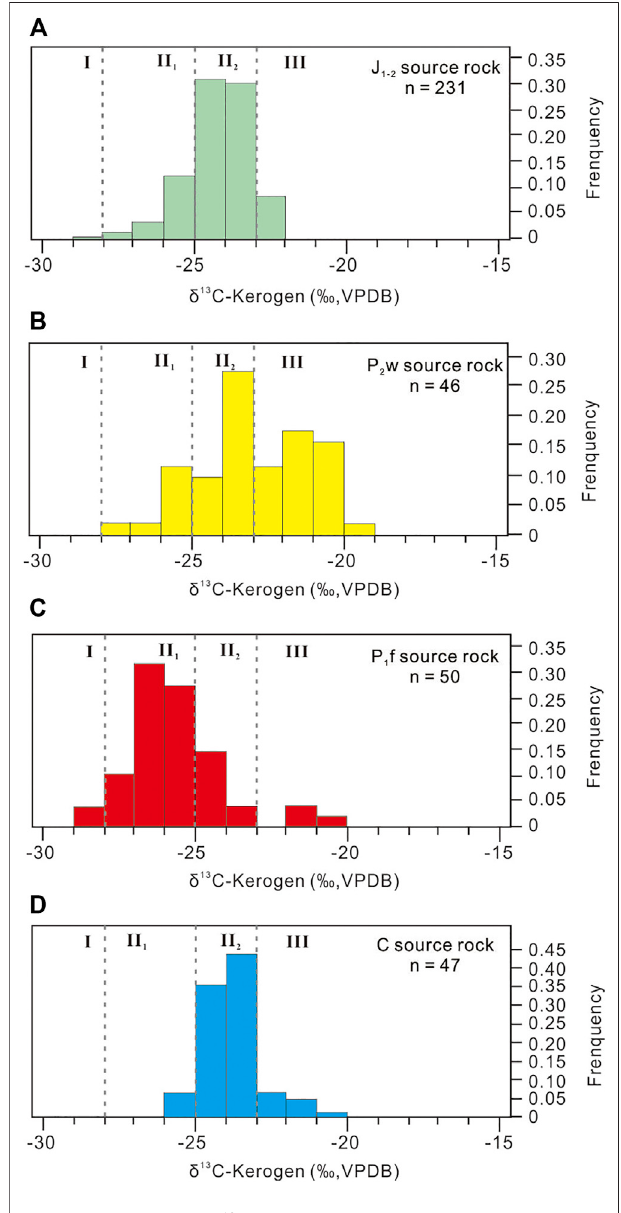
FIGURE 5 | Histogram of δ 13 C kerogen values of primary (A) J 1-2 , (B) P 2 w, (C) P 1 f, and (D) C source rocks in the hinterland of Junggar Basin.